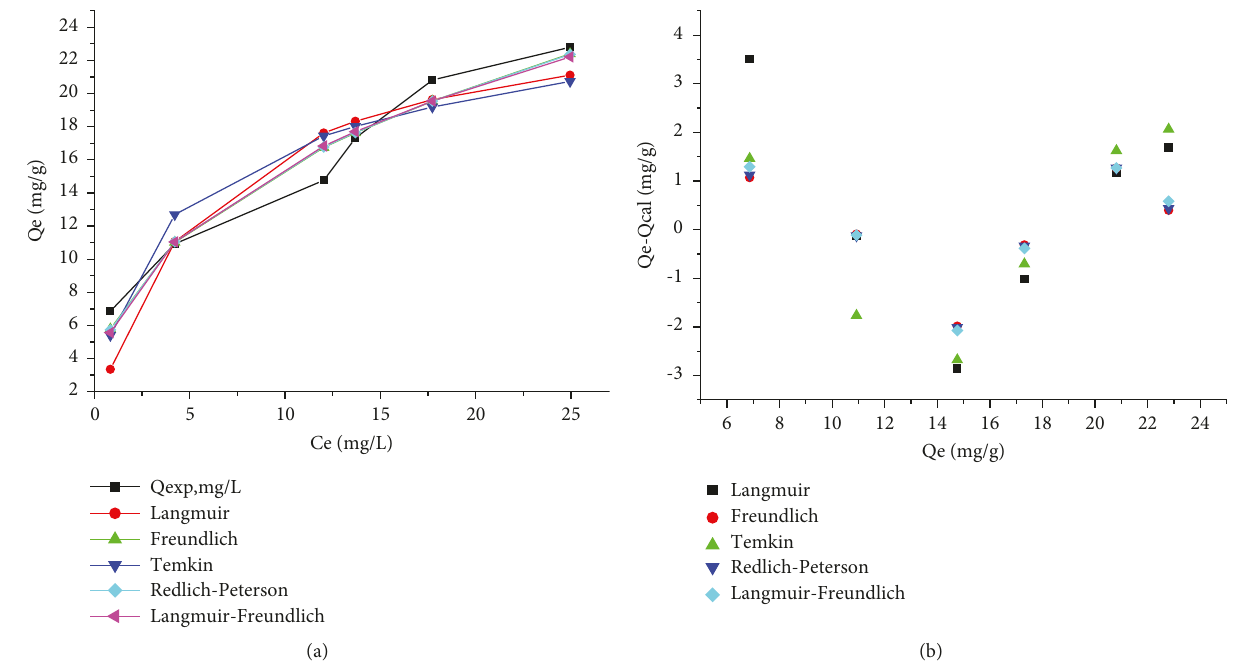
Figure 7: Non-linear isotherm (a) and residual (b) plot for copper(II) tartrate